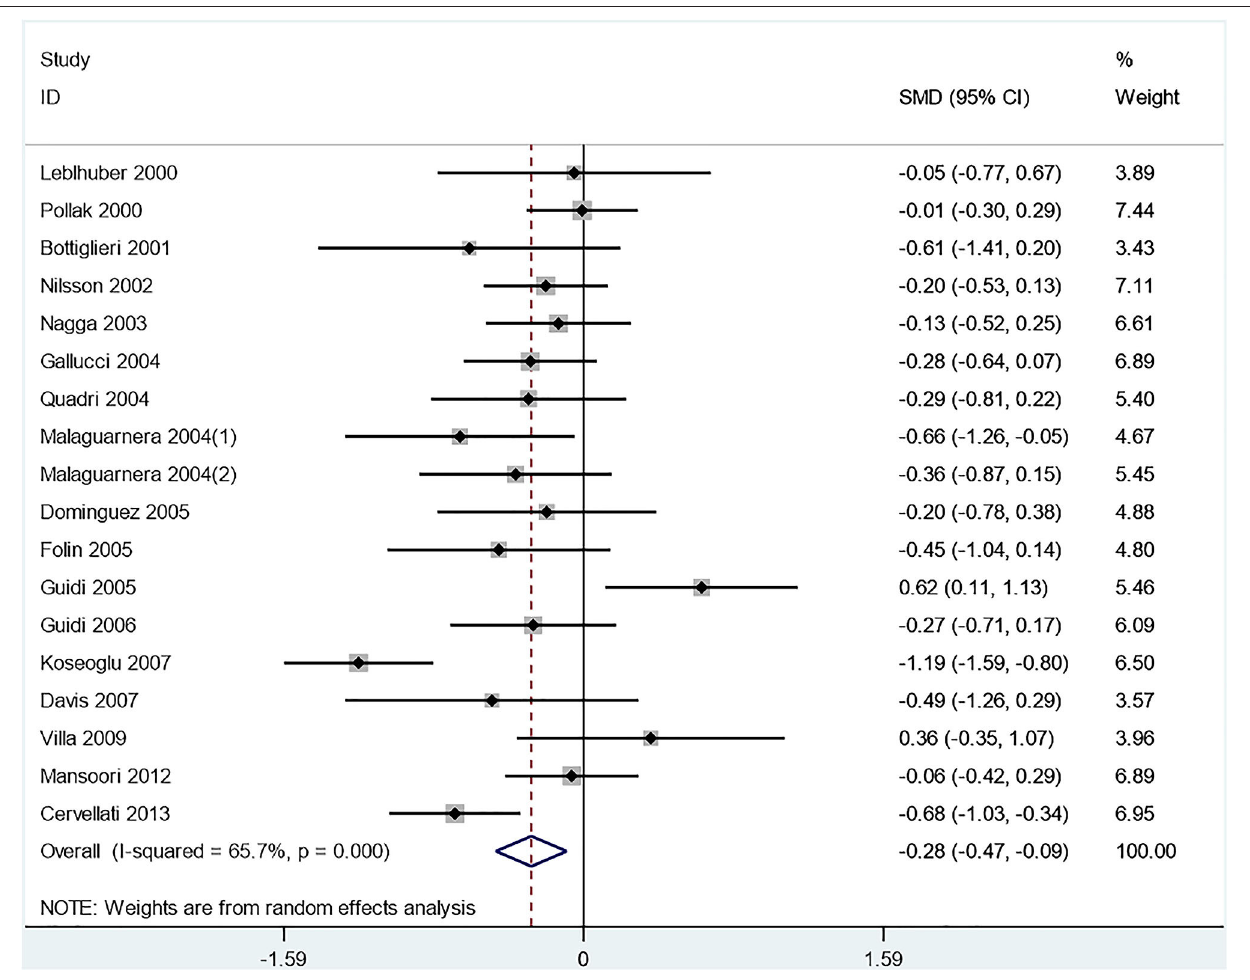
FIGURE 4 | Forest plot of standard mean difference (SMD) and 95% confidence interval (95%CI) in AD and VaD for plasma